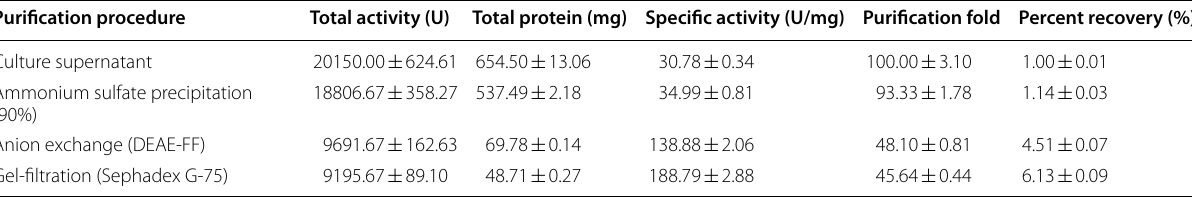
Table 1 Results of the purification of extracellular laccase from C. gallica Purification